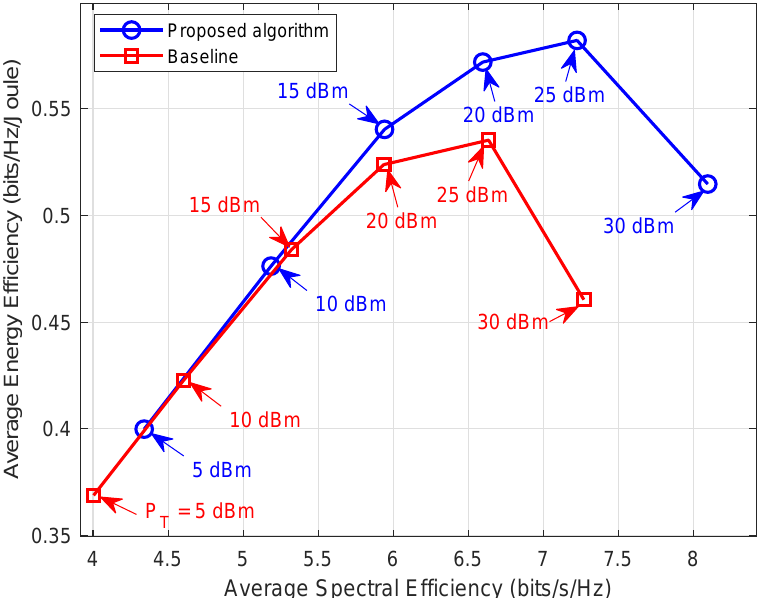
Figure 4. Average EE-SE trade-offs under proposed algorithm and baseline, with a =